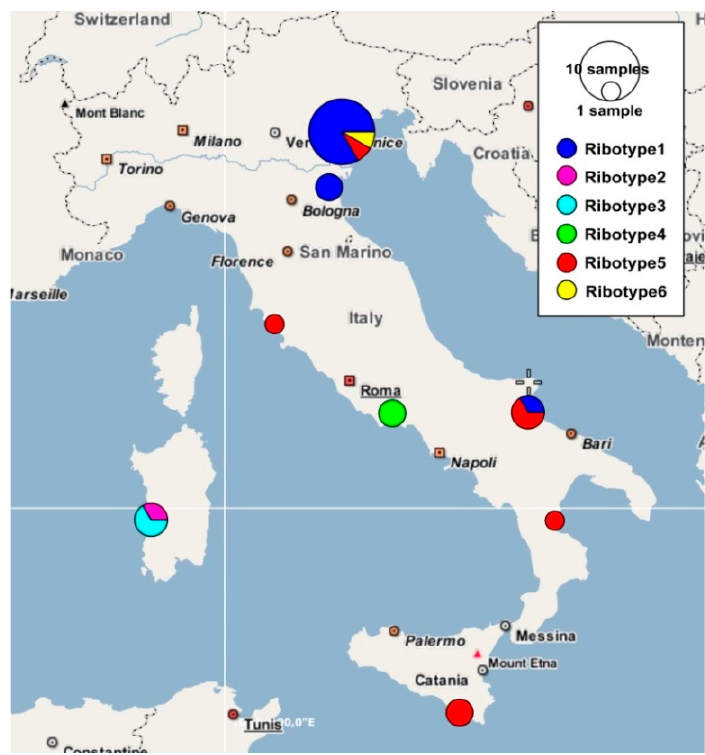
Figure 5. Frequencies of different ETS ribotypes plotted in a geographical map for the genus Salicornia .